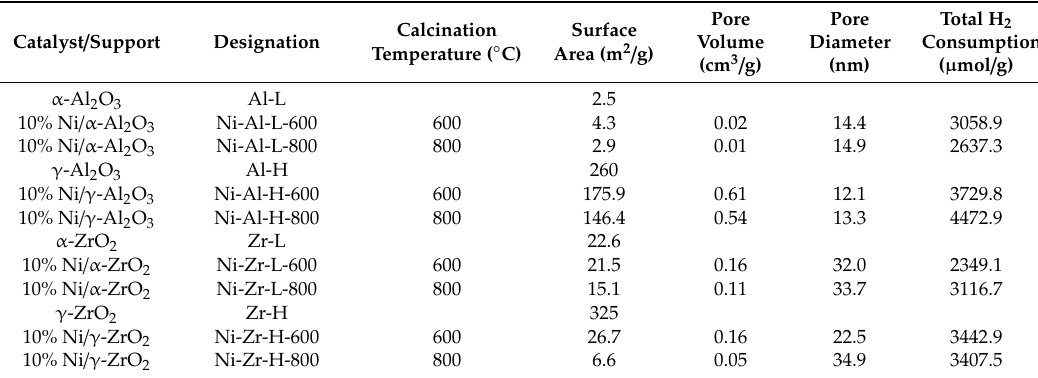
Table 1. Properties of the used